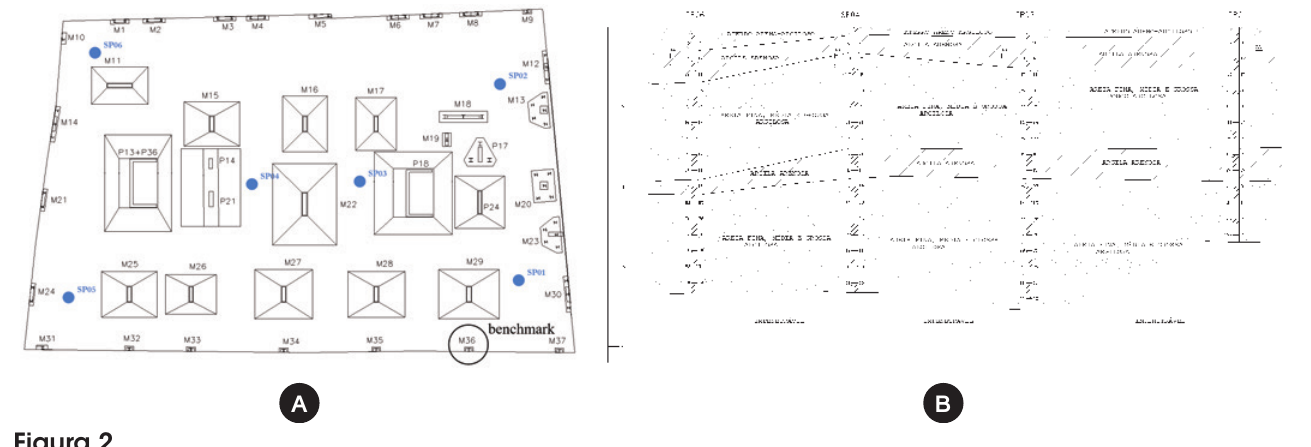
A (a) Foundation plan; (b) Geotechnical profile